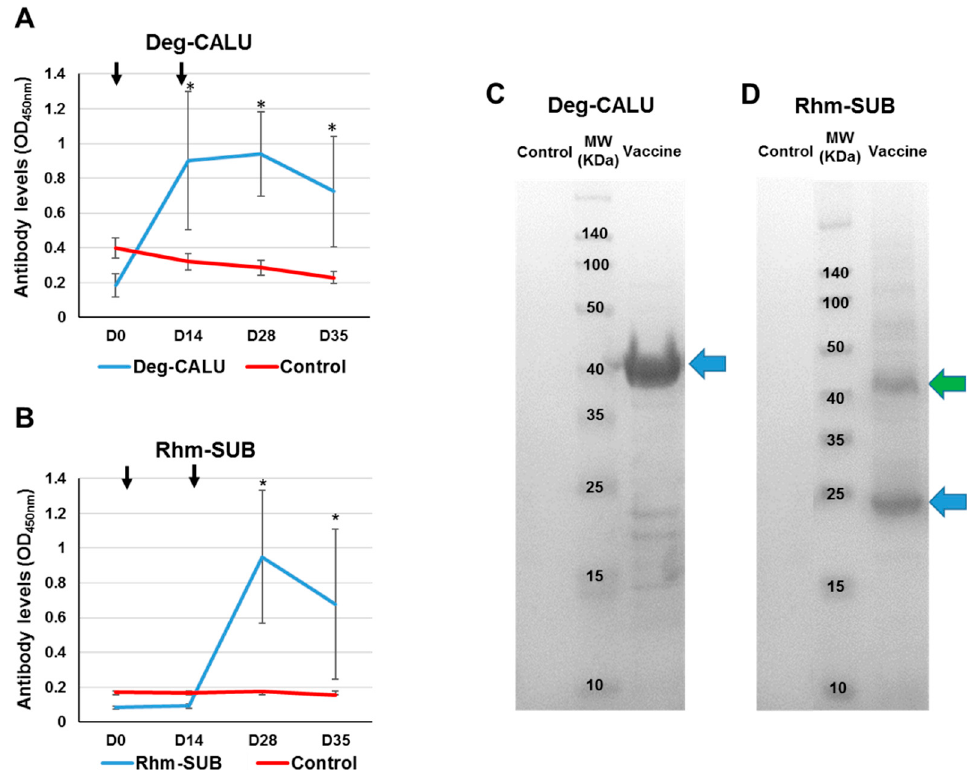
Figure 7. Characterization of the immune response against recombinant vaccines. Antibody levels were determined by ELISA in vaccinated and control hens against Deg-CALU ( A ) and Rhm-SUB ( B ). Serum samples were collected before each vaccination (arrows) (D0 and D14), during mite infestation (D28) and at the end of the experiment. Antibody titers are represented as the average OD450nm ± SD of three replicates and compared between vaccinated and control groups by Mann-Whitney U test (* p < 0.05). Serum samples for control group are pooled. Characterisation by Western Blot of anti-Deg-CALU IgY ( C ) and anti-Rhm-SUB ( D ). Ten µg of protein were loaded per well in a SDS-12% polyacrylamide gel. The gel was used for Western Blot analysis (WB) using sera of vaccinated and control hens collected on day 28 after V1. The position of the recombinant proteins is indicated with blue arrows. The green arrow indicates the potential presence of Subolesin dimers.